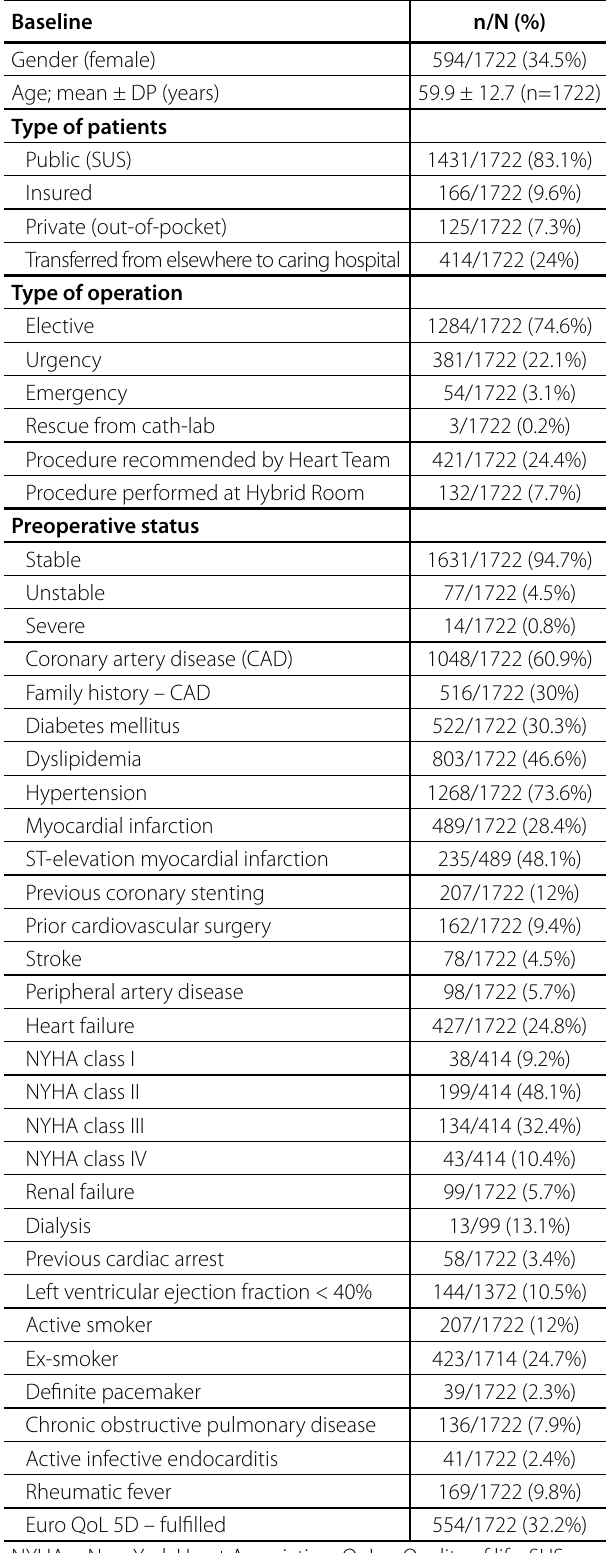
Table 1. Participating sites and Principal Investigators (PI). Table 2. Patient’s characteristics and procedural